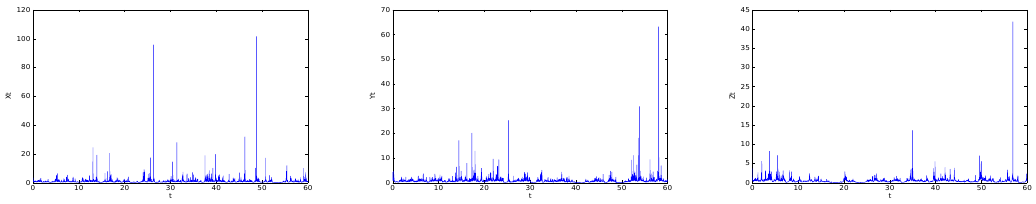
Figure 1: Sample paths of x w